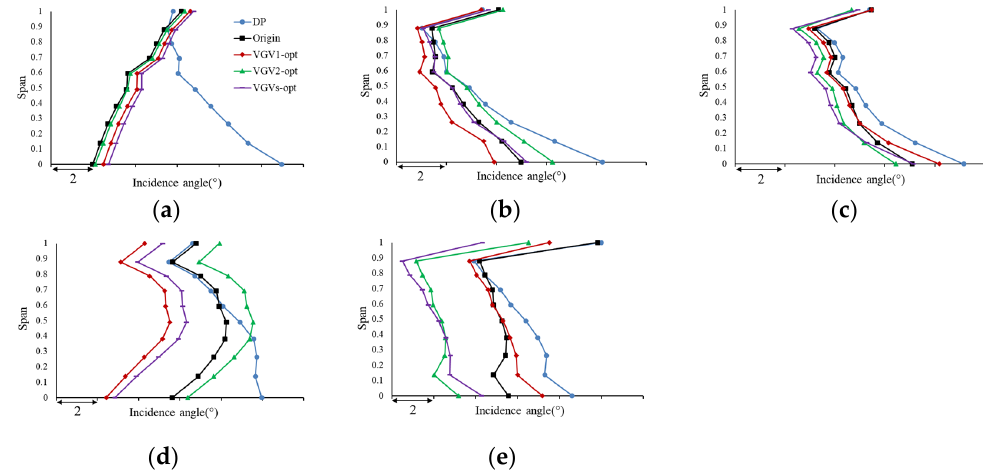
Figure 24. Incidence spanwise distribution (VGV joint adjustment). ( a ) R1; ( b ) R2; ( c ) R3; ( d ) S1; ( e ) S2.